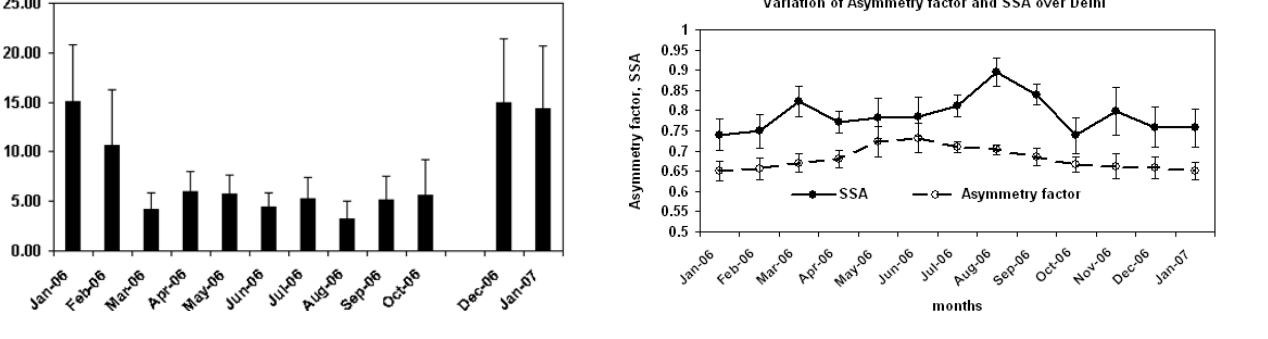
Fig. 5. Variation of monthly averages of single scattering albedo (SSA) and Asymmetry factor estimated over Delhi during Jan 06 to Jan 07.